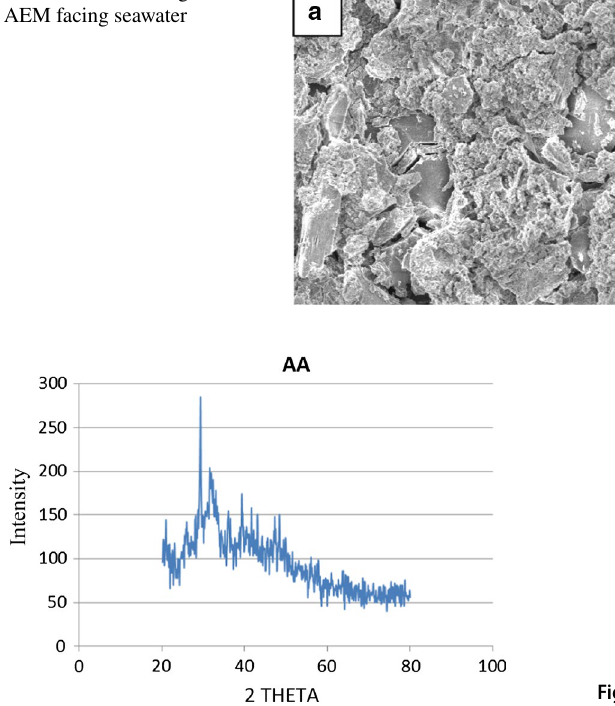
Fig. 11 a and b SEM images of used AEM facing seawater